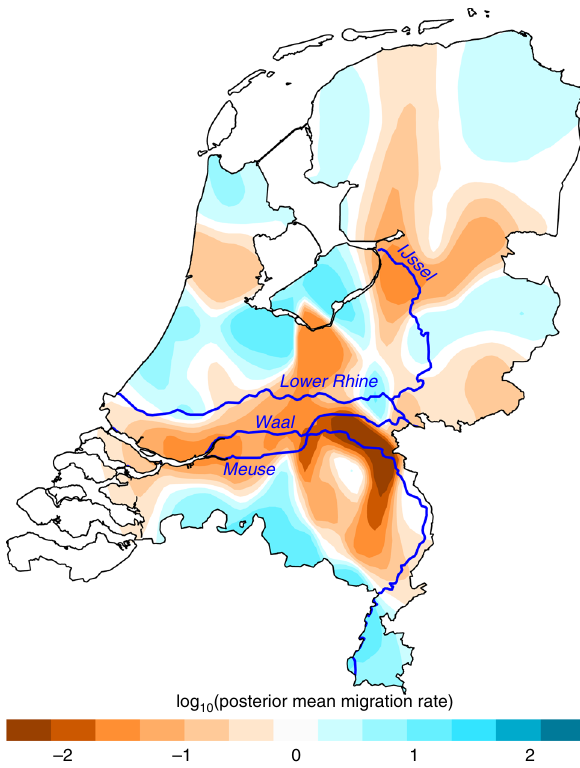
Fig. 5 The effective migration surface of the Netherlands. Contour map shows the mean of 10 independent EEMS posterior migration rate estimates between 800 demes modelled over the land surface of the Netherlands. A value of 1 (blue) indicates a tenfold greater migration rate over the average; − 1 (orange) indicates tenfold lower migration than average. The courses of major rivers are included to highlight their correlation with migrational cold spots. Map boundary data from the Database of Global Administrative Areas (GADM; https://gadm.org); river course data from Natural Earth corresponds to the geographical division determining the prin- cipal fi neSTRUCTURE split between northern and southern Dutch populations (Fig. 4a) as well as the geographical bound- aries between clusters inferred from ancient IBD segments (Fig. 3b), suggesting that these rivers have been a historically persistent determinant of Dutch population structure.